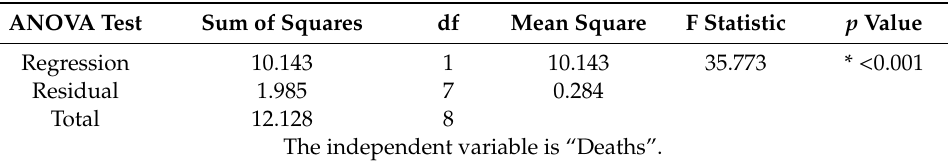
Table 5. The exponential regression model for the NRP+ group.